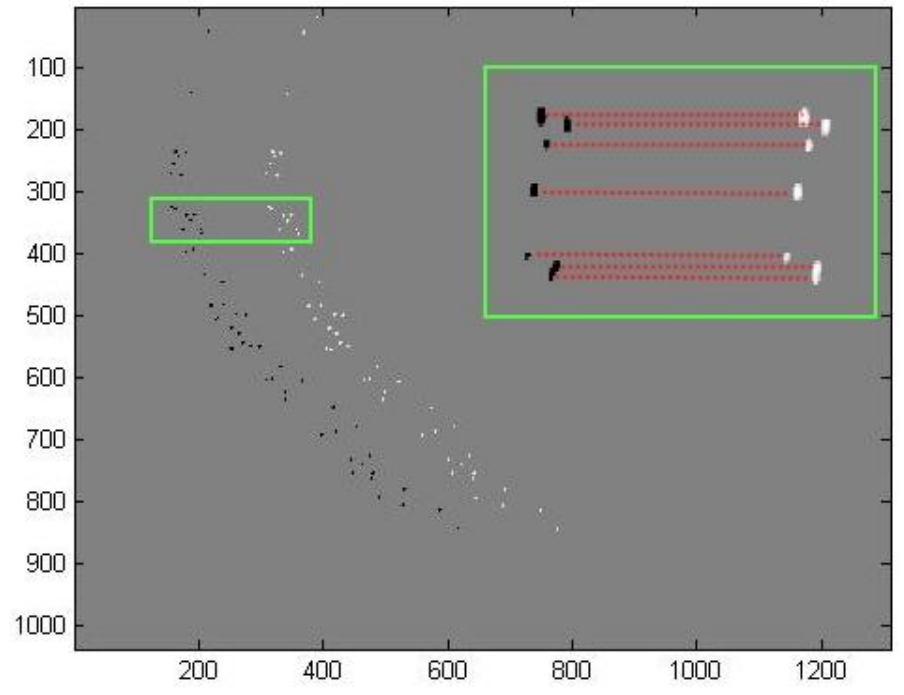
Figure 3. Illustration of stereo matching. For clarity, left and right images are superimposed. Black and white particles represent particles visualized by the right and left camera, respectively. The search for matches is done over horizontal scan